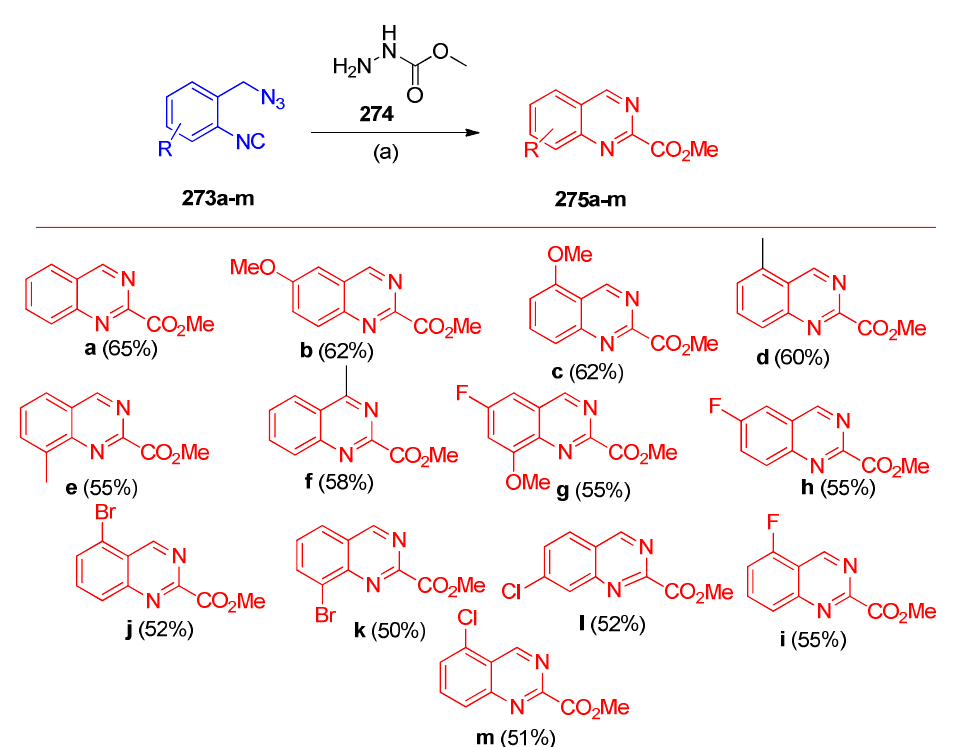
Scheme 109. Synthesis of quinazoline derivatives 275a – m . Reagents and conditions : (a) Mn(OAc) 3 · 2H 2 O (0.63 mmol), TBHP (1.89 mmol, 5 M in decan), and EtOAc, 12 h at 80 ◦ C. is illustrated in Scheme 110. Initially, the